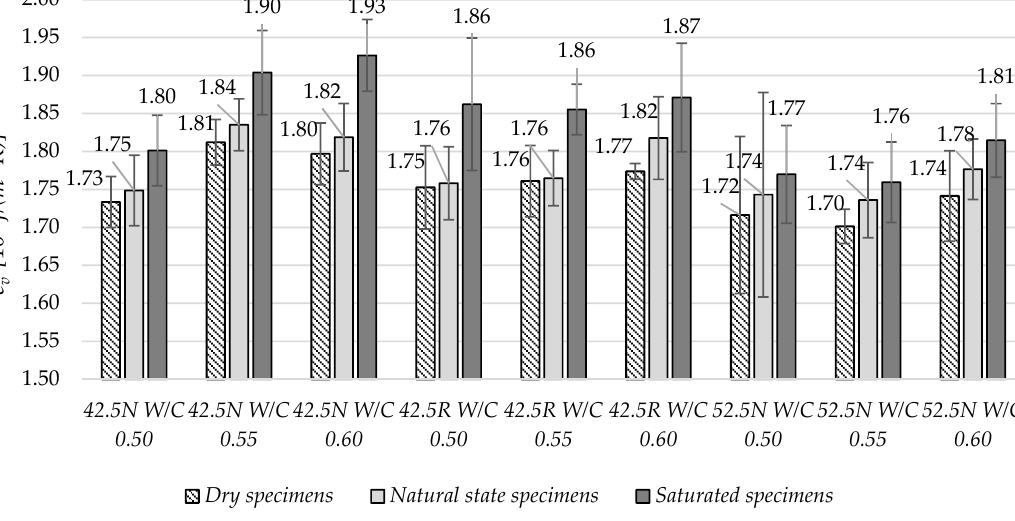
Figure 6. The average volumetric specific heat values in three moisture states.